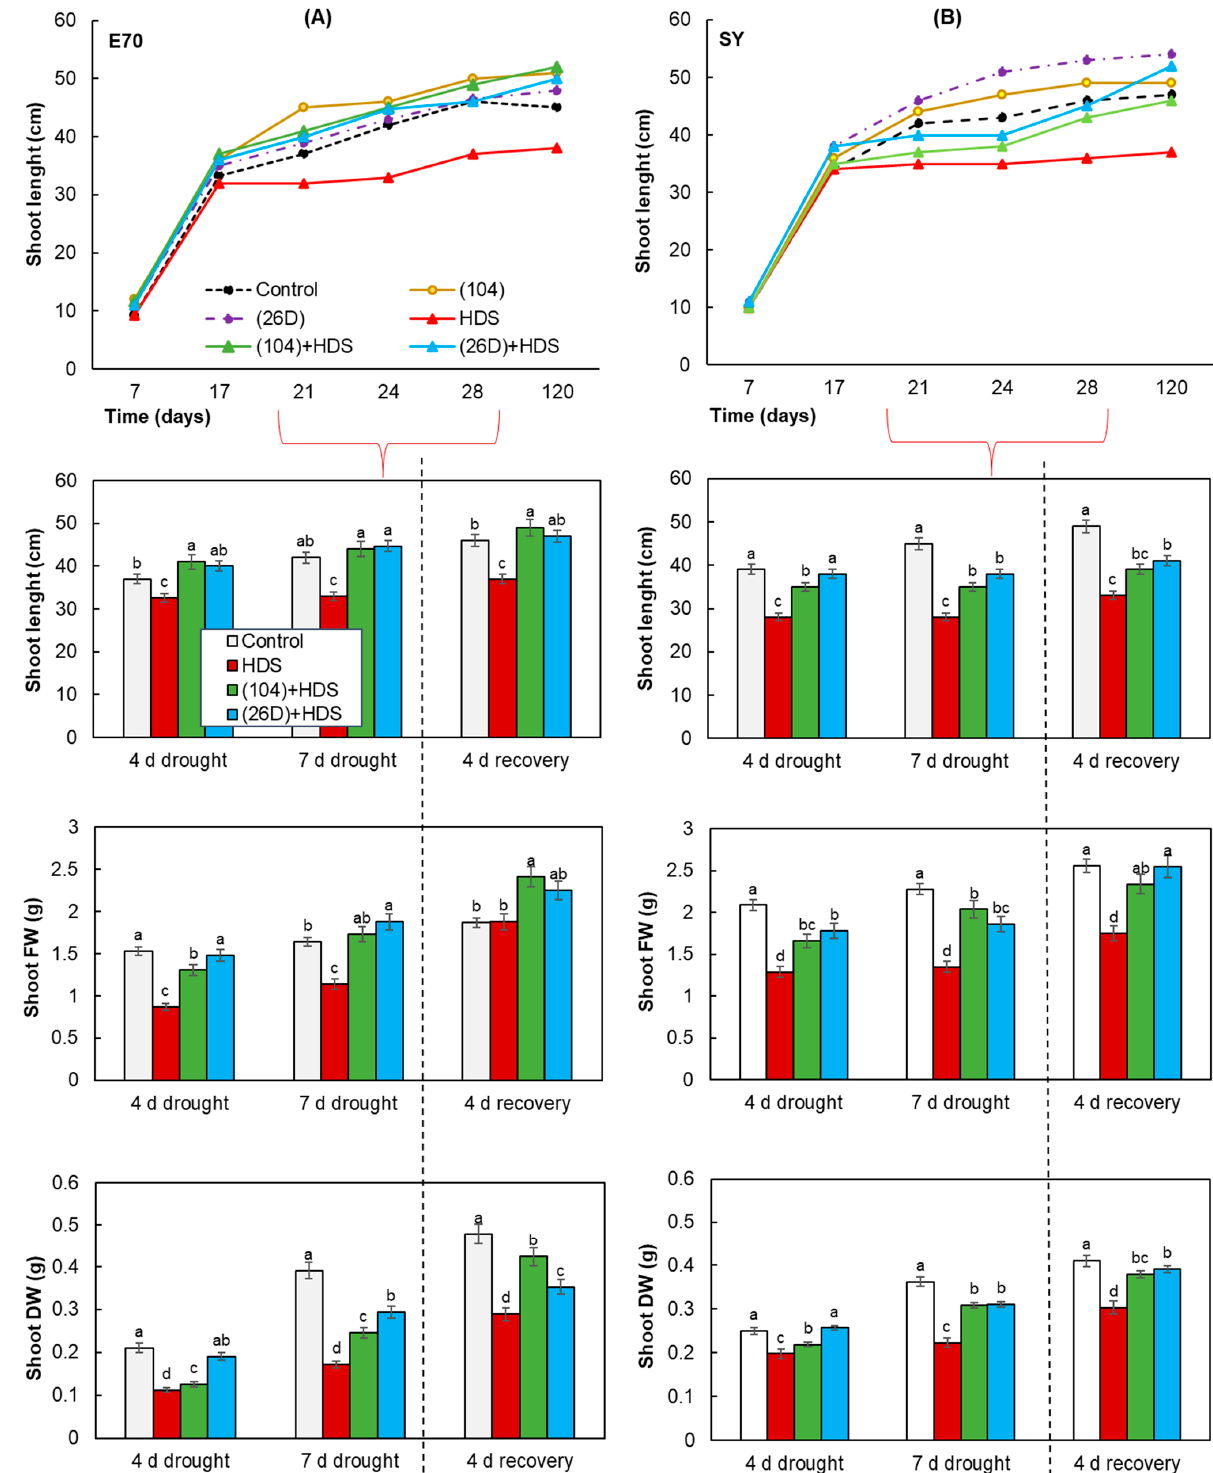
Figure 3. Influence of B. subtilis 104 and 26D on growth (length, fresh, and dry weights) of underground part (shoots) of two spring wheat varieties E70 ( A ) and SY ( B ) under combined herbicide + drought stress (HDS), as well as in the post-stress period (4 d recovery) after the resumption of normal watering. Error bars represent standard errors (±SE) of the means in triplicate. Growth parameters were measured using 25 plants from each replicate. Various le tt ers show a signi fi cant di ff erence between the averages of di ff erent groups at p < 0.05.